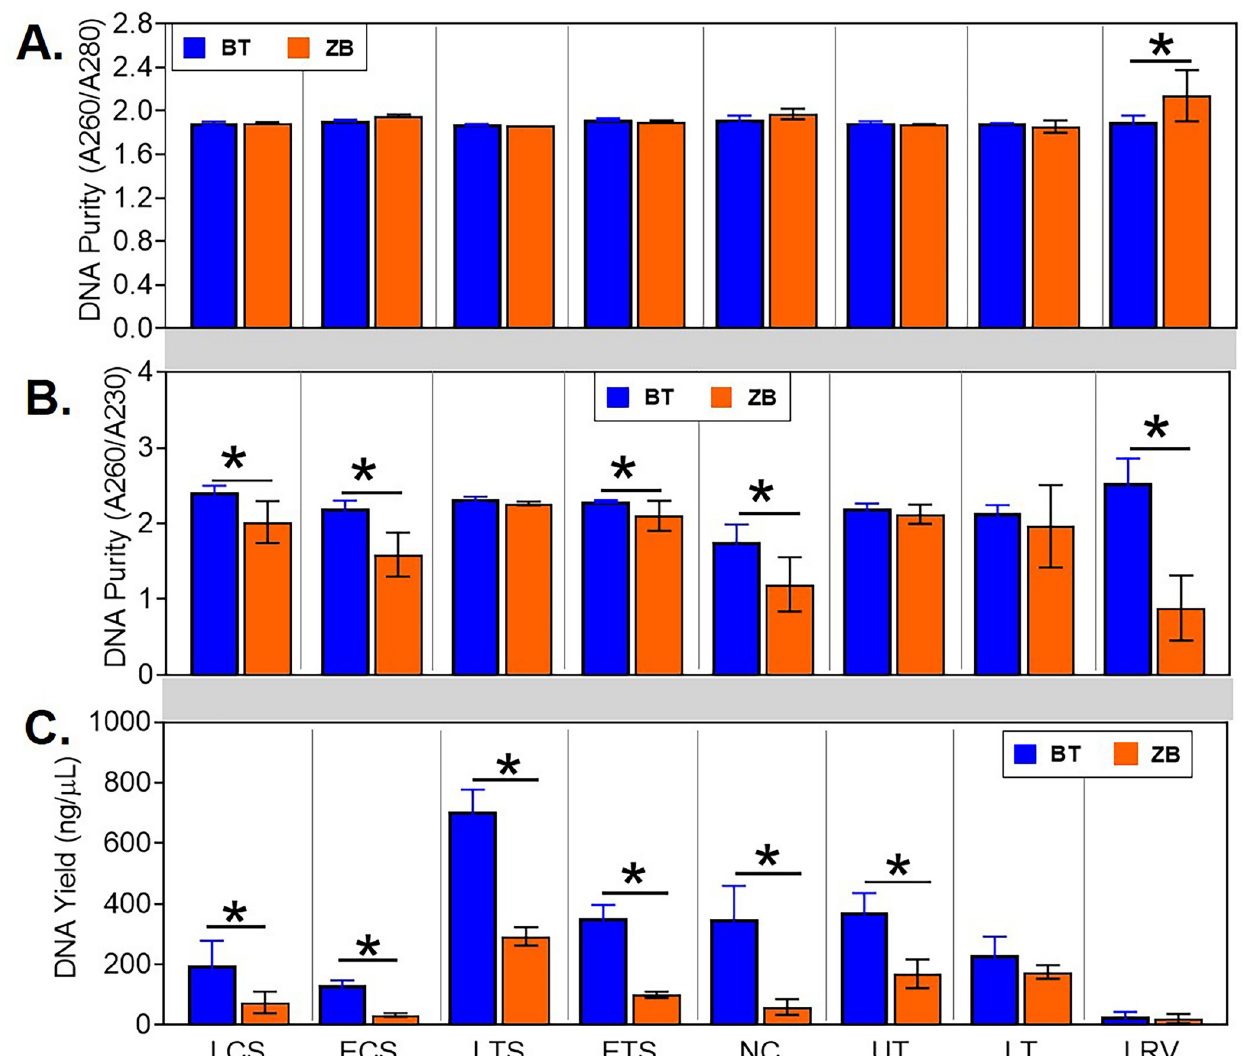
Fig 2. Comparison of quantity and quality of DNA from samples extracted using the ZB and BT kits. The elution volume was standardized to 50 μ L for both kits. DNA quality was expressed as ratios of absorbances at (A) 260nm and 280nm wavelengths (A260/A280) and (B) 260nm and 230nm wavelengths (A260/A230). (C) DNA yield was expressed as mass per unit volume (ng/ μ L). Statistical differences, � p < 0.05 (pairwise Kruskal-Wallis tests, with a Benjamini-Hochberg correction for false discovery). LCS, live choanal swab; ECS, euthanized choanal swab; LTS, live tracheal swab; ETS, euthanized tracheal swab; NC, nasal cavity wash; UT, upper trachea wash; LT, lower trachea wash; LRV, lower respiratory lavage.